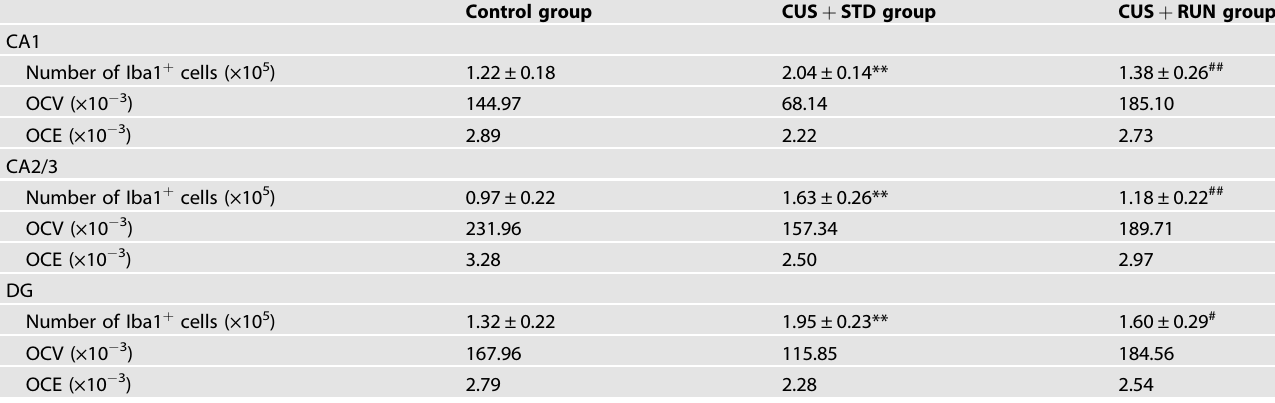
Table 4. Stereological results of the total numbers of Iba1 + cells in the hippocampus.